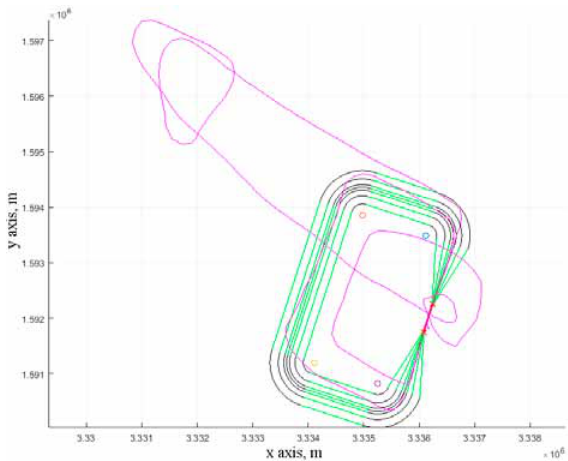
Fig. 5. Programmed model of pilot circuit flight assessment in the ECEF coordinate system